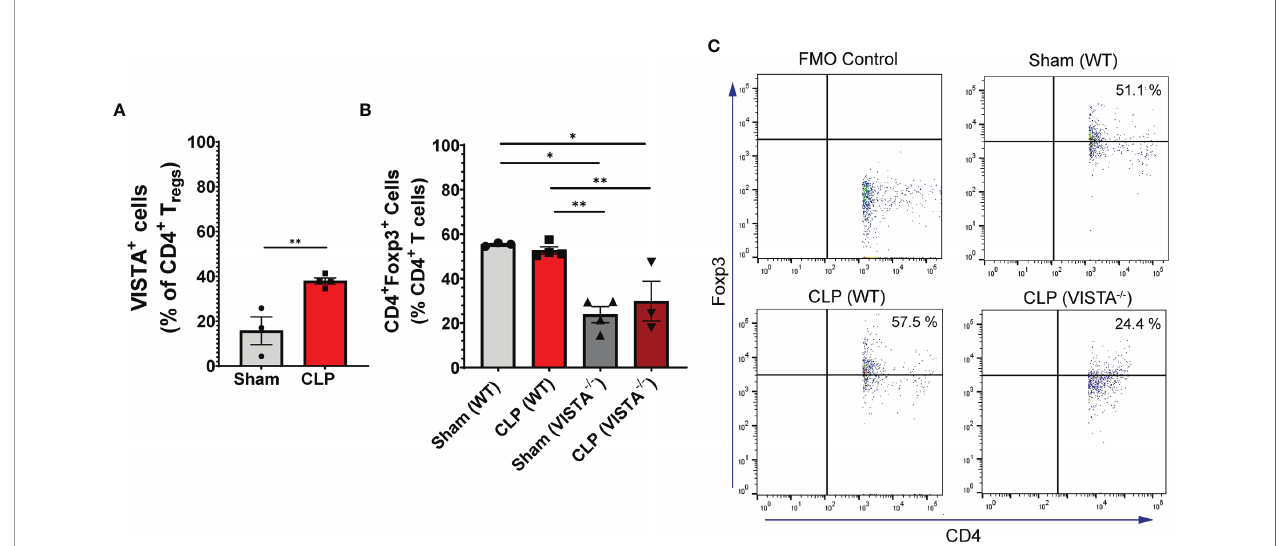
FIGURE 4 | VISTA expression correlates with CD4 + T reg population increase following CLP and VISTA -/- mice fail to expand the CD4 + T reg population in the intestinal intraepithelial compartment. (A) Summary graph of VISTA + CD4 + T reg frequency in the small intestine. (B) Summary graph of CD4 + T reg frequency in the small intestine and (C) representative fl ow cytometry plots comparing fl uorescence minus one (FMO) control, sham (WT), CLP (WT), and CLP (VISTA -/- ) samples. Summary graphs show mean ± SEM [WT-sham: n = 3 , WT-CLP: n = 3 , VISTA -/- sham: n = 4 , VISTA -/- -CLP: n = 4 ]; signi fi cance *p < 0.05; **p <